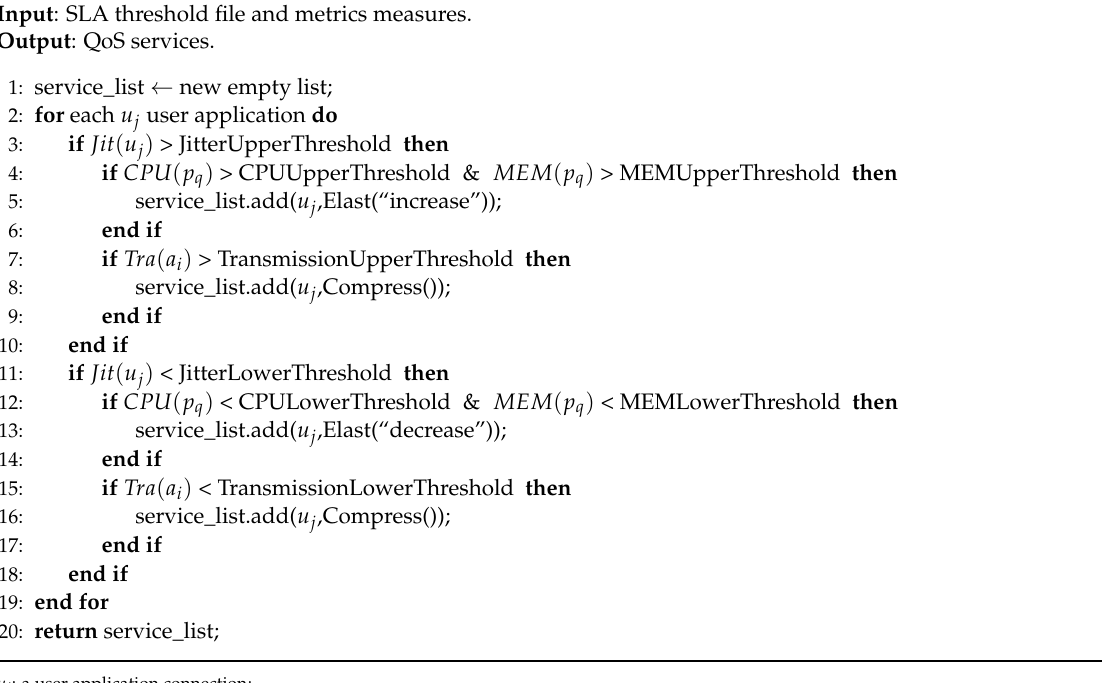
Algorithm 3 User Orchestration Execution